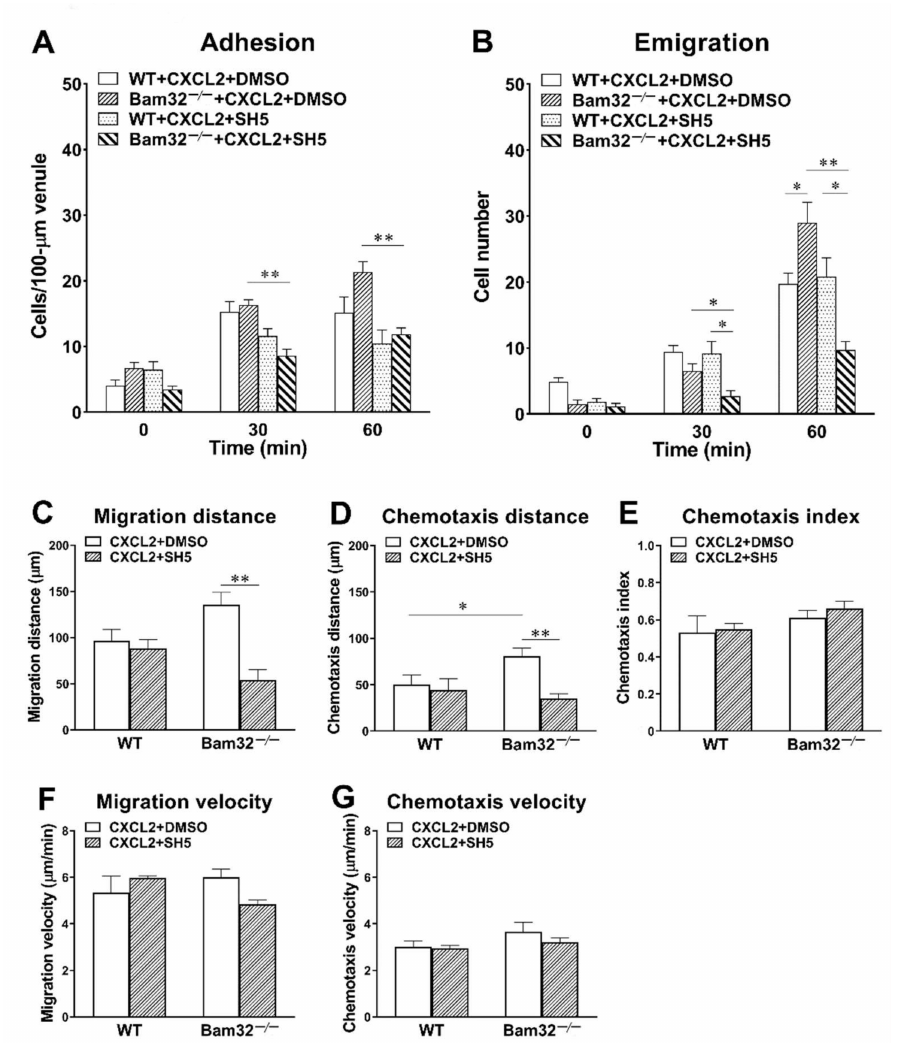
Figure 7. Effect of Akt inhibition on CXCL2-induced neutrophil recruitment in the mouse cremaster muscle. ( A ) The number of adherent neutrophils (cells/100- µ m venule) and ( B ) the number of emigrated neutrophils (cells/235 × 208 µ m 2 field) before (0 min) and at 30 and 60 min following the placement and holding of CXCL2-containing gel on the cremaster muscle of WT and Bam32 − / − mice superfused with DMSO (vehicle) or the specific pan-Akt inhibitor SH-5 (1 µ M) for 30 min prior to and throughout the 60-min CXCL2 stimulation. ( C − G ) The migration distance, chemotaxis distance, chemotaxis index, migration velocity, and chemotaxis velocity of neutrophils in extravascular tissue during 60 min following the placement of CXCL2-containing gel on the cremaster muscle of WT and Bam32 − / − mice (averaged from >50 cells) superfused with DMSO (vehicle) or SH-5 (1 µ M) for 30 min prior to and throughout the 60-min CXCL2 stimulation. ( A − G ): mean ± SEM of 4 mice per group. * and ** indicate significant differences ( p < 0.05 and p < 0.01, respectively) between treatments with DMSO (vehicle) and SH-5 ( C − G ) in CXCL2-treated Bam32 − / −